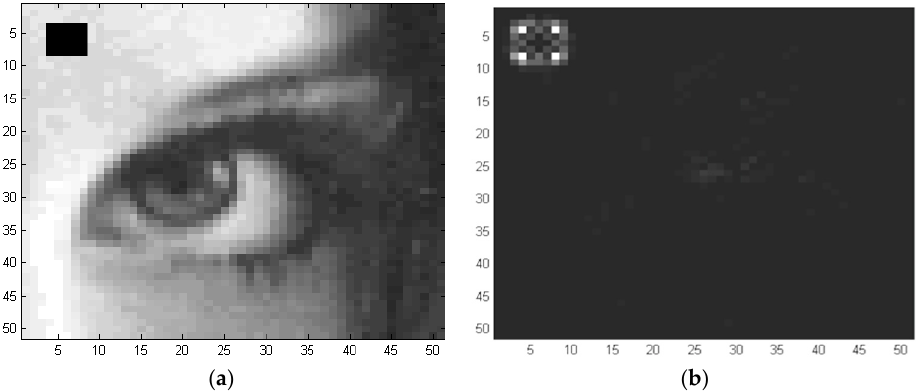
Figure 11. Reconstruction from few control points by using global TPS algorithm: ( a ) Low resolution image containing 26 × 26 Pixels 2 ; ( b ) Reconstructed at a higher resolution of 260 × 260 Pixels 2 .